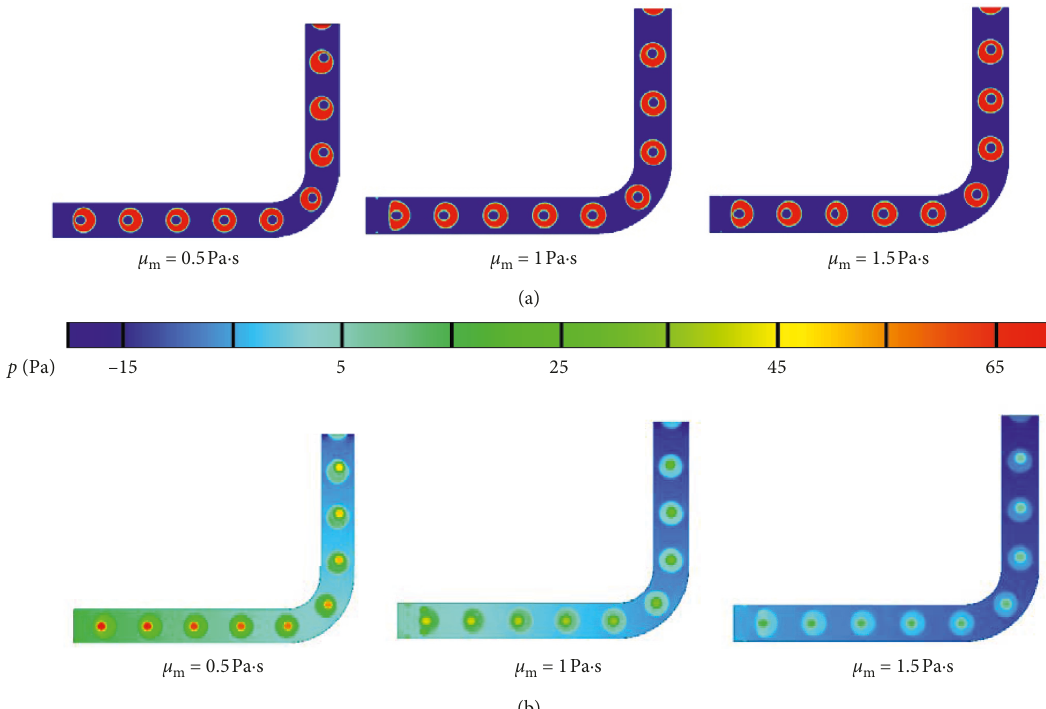
Figure 11: Effect of the viscosity of the middle phase on the compound droplet deformation: (a) interface shape; (b) pressure